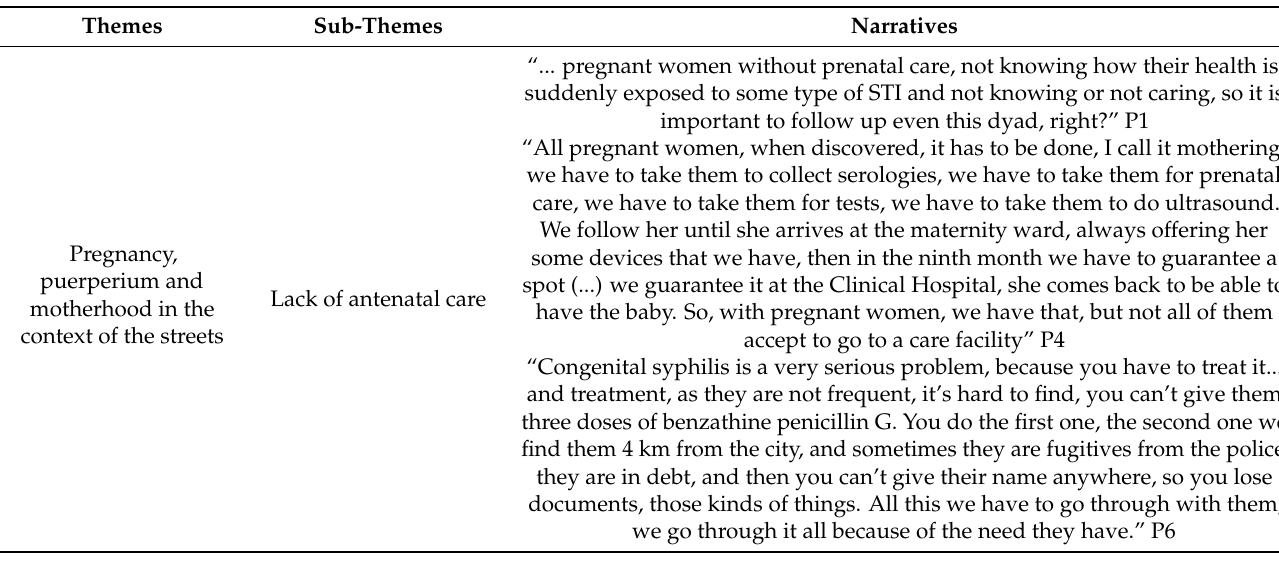
Table 3. Some narratives from participants related to pregnancy, puerperium and motherhood in a homelessness